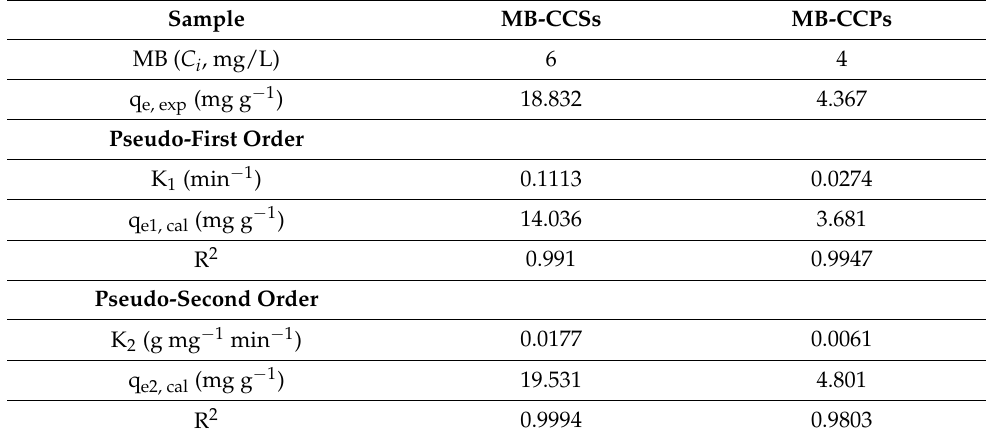
Table 6. Kinetic parameters for the biosorption of MB dye onto CCSs and CCPs.